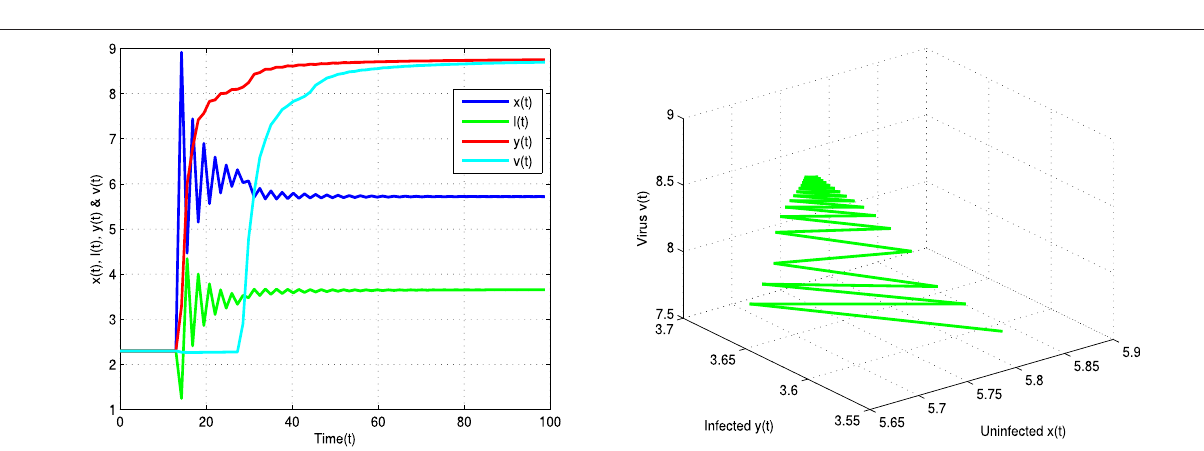
FIGURE3| Timeandspaceplanetrajectoriesforuninfectedcells x ( t ),latentlyinfectedcells l ( t ),infectedcells y ( t ),andviruses v ( t )of Eq.2 with τ (cid:2) 13 < τ * (cid:2) 13.5and α (cid:2) 0.9.